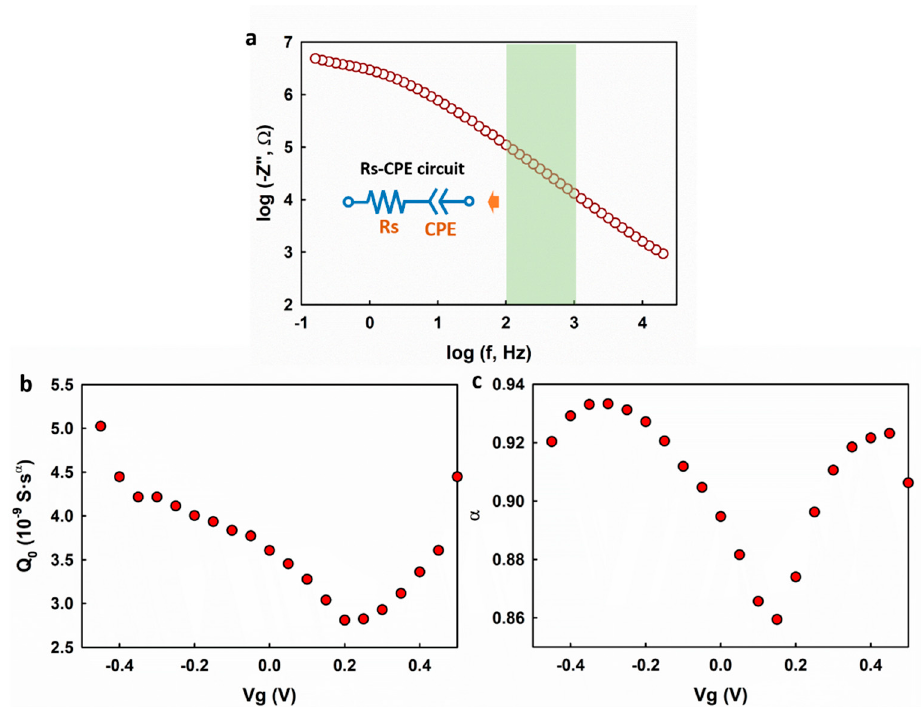
Figure 3. ( a ) log ( − Z (cid:48)(cid:48) ) . vs. log f plot with the linear range for fitting highlighted in green; ( b , c ) the Figure 3. ( a ) log(cid:4666)(cid:3398)𝑍”(cid:4667) vs log𝑓 plot with the linear range for fitting highlighted in green; ( b , c ) the extracted Q 0 and α by fitting the impedance spectrum using the Rs-CPE extracted 𝑄 0 and α by fitting the impedance spectrum using the Rs-CPE model.